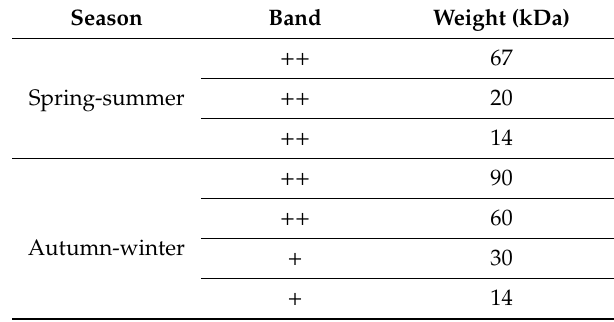
Figure 12. Electropherogram of the investigated protein samples in the autumn-winter period. Table 2. Qualitative and quantitative changes in mucus proteins depending on the